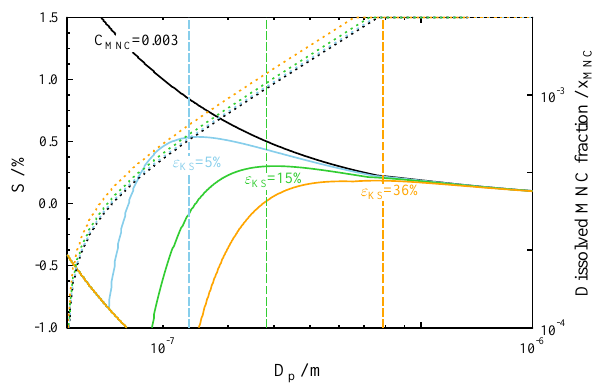
Figure 3. Example Köhler curves (solid lines) calculated from Eq. (1) for pure MNC (black), MNC mixed with 5% (blue), 15% (green), and 36% (orange) by volume KS. The dotted lines are the dissolved fractions of MNC, x MNC , calculated from Eq. (7), corre- sponding to the different Köhler curves. The vertical dashed lines indicate the maxima of the different Köhler curves. The dry diame- ter applied is 110nm.